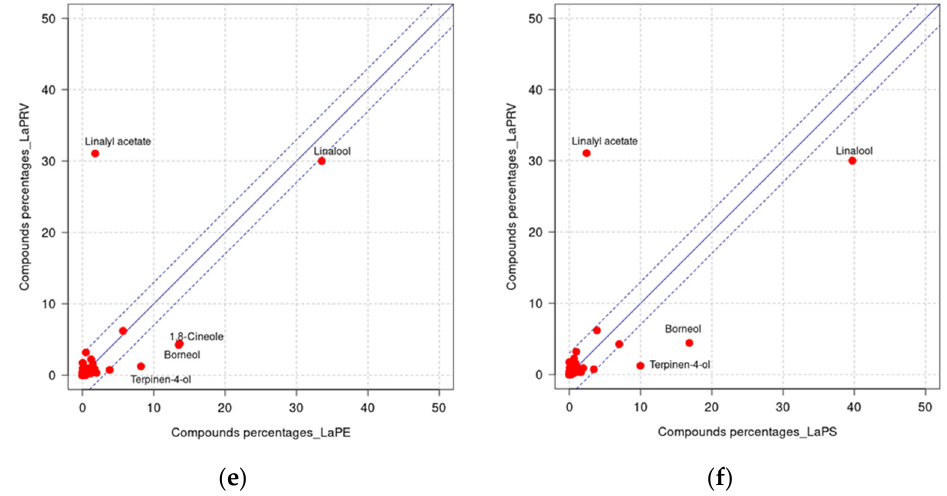
Figure 2. Cross plots between compositions, EO LaX compound percentages vs. EO LaY compound percentages, where X and Y represent different lavenders: LaCC vs. LaPE ( a ); LaCC vs. LaPS ( b ); LaCC vs. LaPRV ( c ); LaPE vs. LaPS ( d ); LaPE vs. LaPRV ( e ); LaPS vs. LaPRV ( f ).